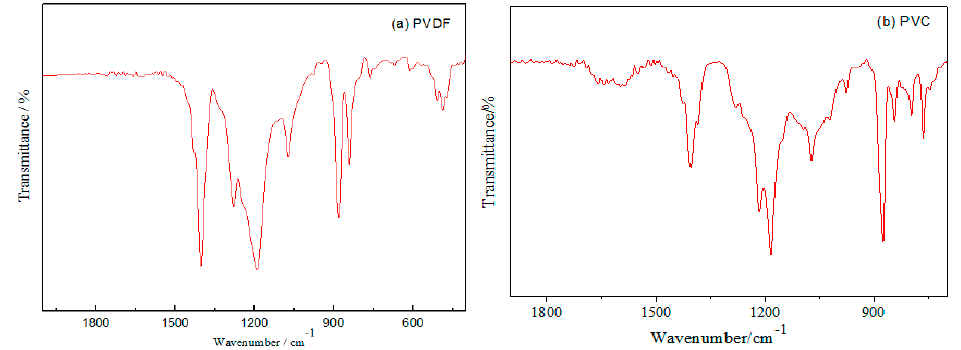
Figure 2. ( a ) FT-IR spectra of PVDF powders; ( b ) FT-IR spectra of PVC